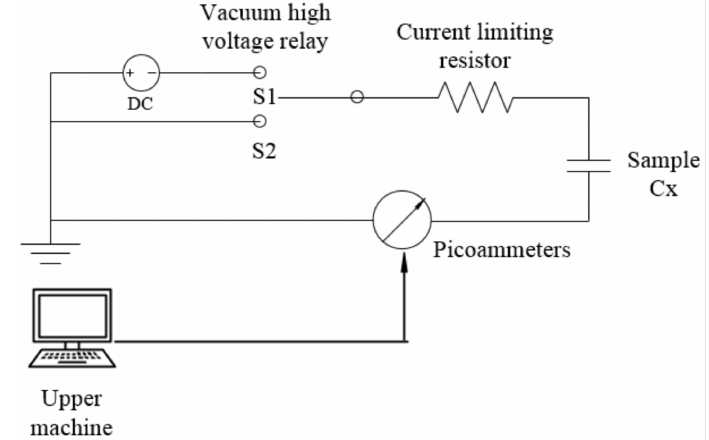
Figure 7. The schematic diagram of PDC measuring